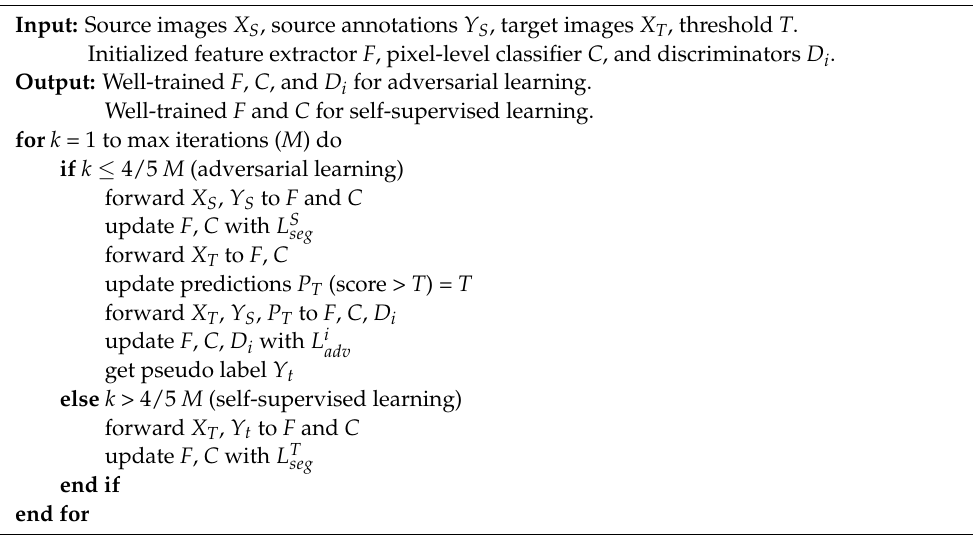
Algorithm 1. Training process for the hybrid